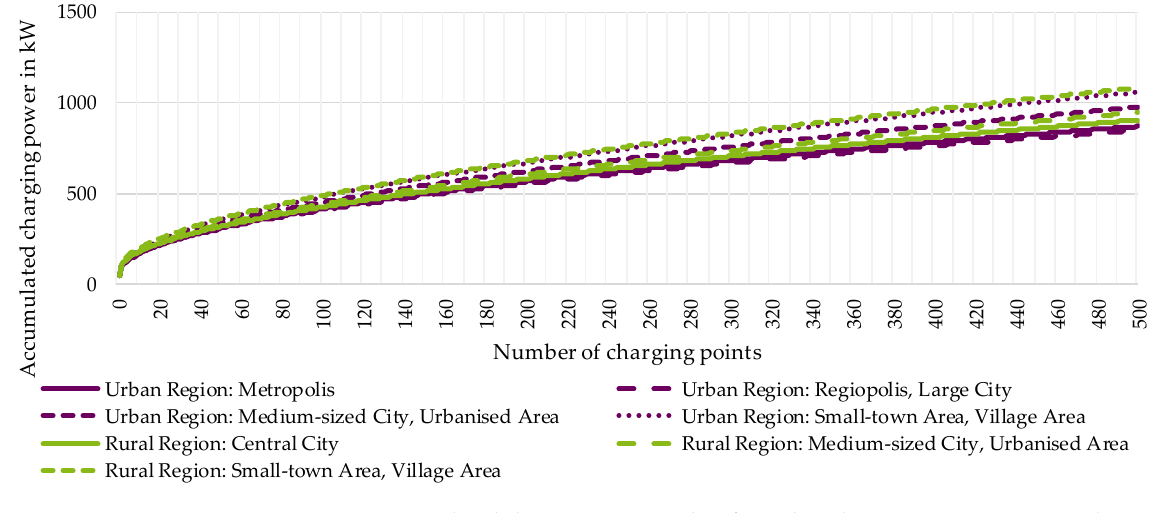
Figure A9. Accumulated charging power in kW for 50 kW charging points up to 500 charging points for seven area types.